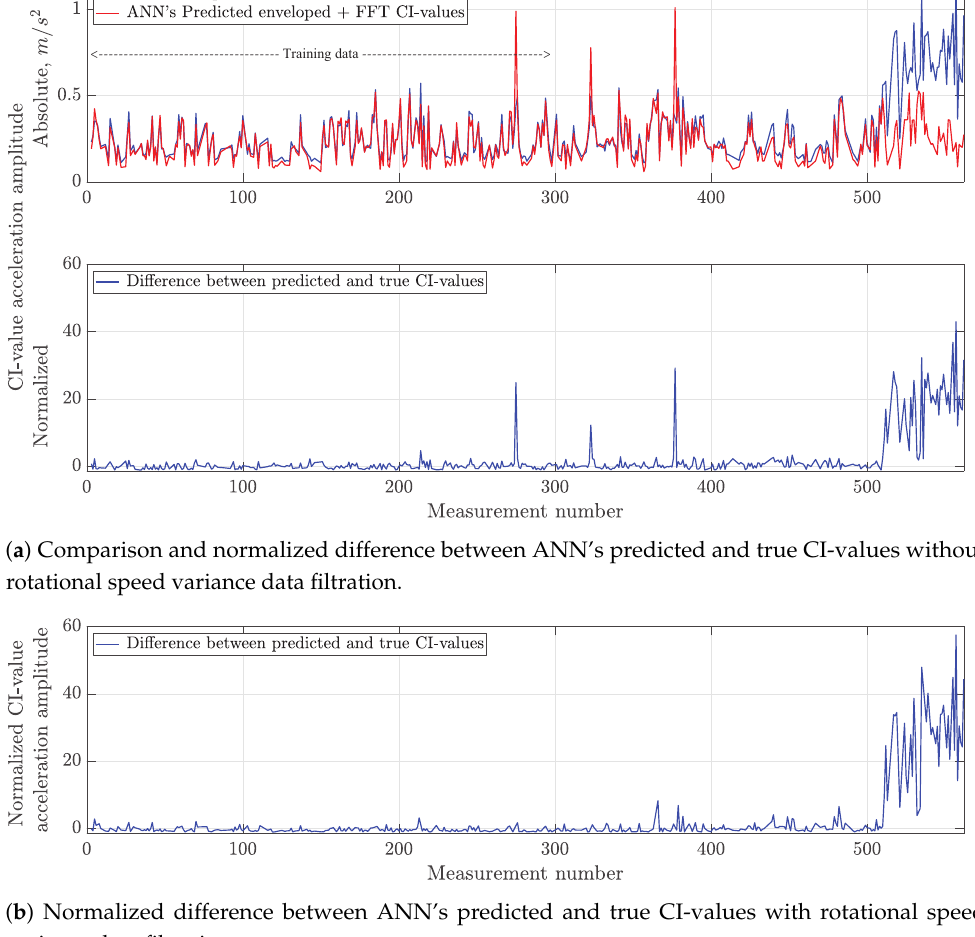
Figure 5. Gearbox output shaft bearing failure case 1, enveloped FFT CI-values. Comparison of ANN’s predicted CI-values in red and true CI-values in blue at the top graph in ( a ) and normalized difference between them at the bottom graph without rotational speed variance data filtration. Normalized difference between predicted and true CI-values with rotational speed variance data filtration in ( b